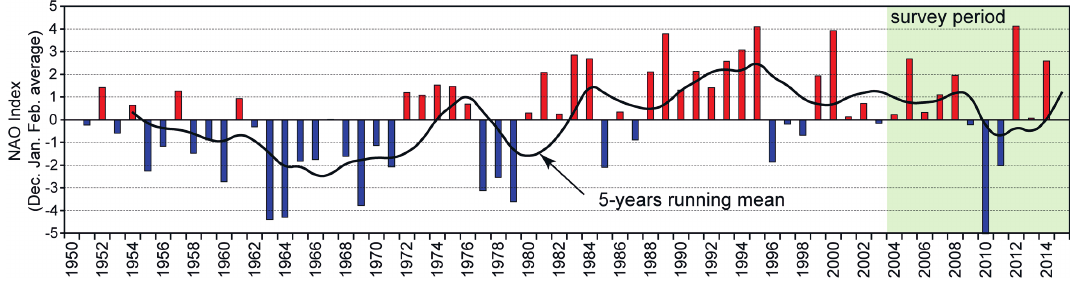
Figure 13. North Atlantic Oscillation Index (NAO) from 1950 to 2015